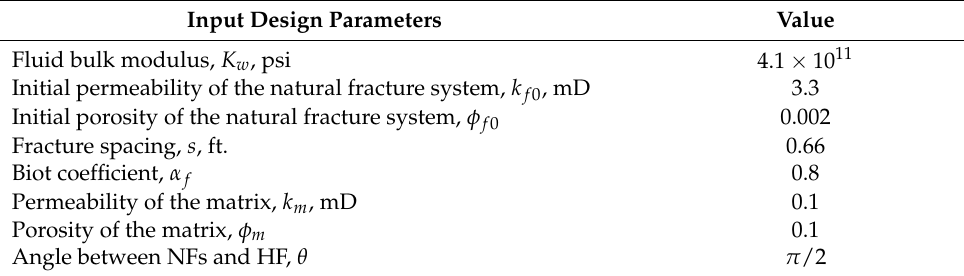
Table 4. Additional input parameters for the dual-porosity